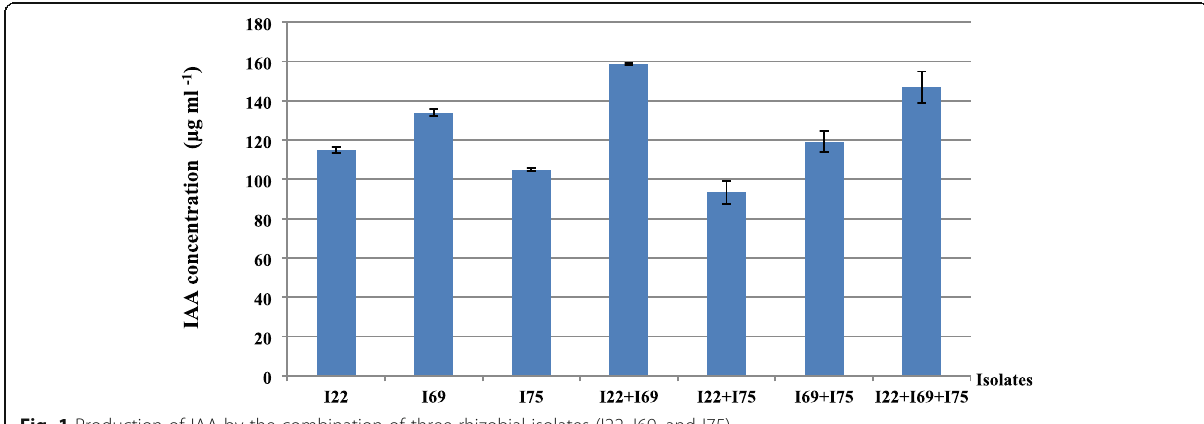
Fig. 1 Production of IAA by the combination of three rhizobial isolates (I22, I69, and